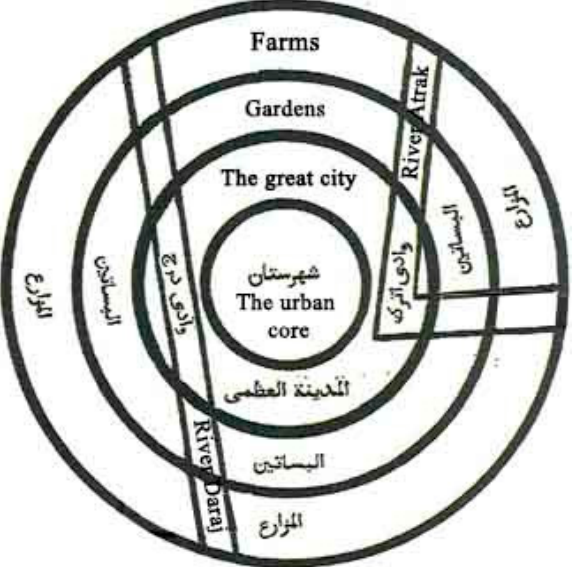
Figure 6. The urban structuring of the Medina of Marrakesh inspired by Qazvin diagram (data source: El Faïz, M. Marrakech: An Ecological Miracle and its Wanton Destruction. In: Gardens, City Life and Culture . Conan, M., Whangheng, C.: Gardens, City Life and Culture: Harvard University Press: Scotland, 2008, pp. 193–201).